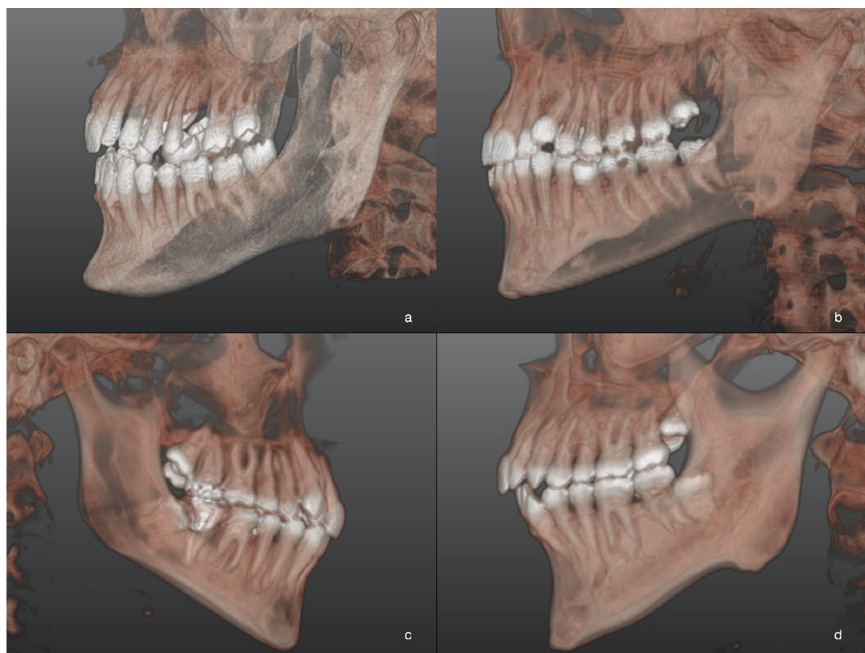
Figure 4. Three-dimensional images of M3M after 3D reconstructions of CBCT scans in patients of L-GA group. Different levels of M3M position in relation to the adjacent alveolar crest were reported: the most superficial M3M, completely erupted ( a ); partially impacted M3M in horizontal position ( b ); completely impacted M3M in the ramus with distoangular position ( c ); the deepest impacted M3M with roots closer to mandibular canal ( d ).